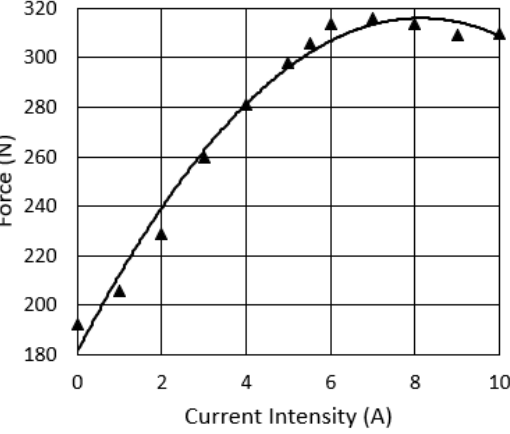
Figure 10. Axial force load vs. coil current intensity.